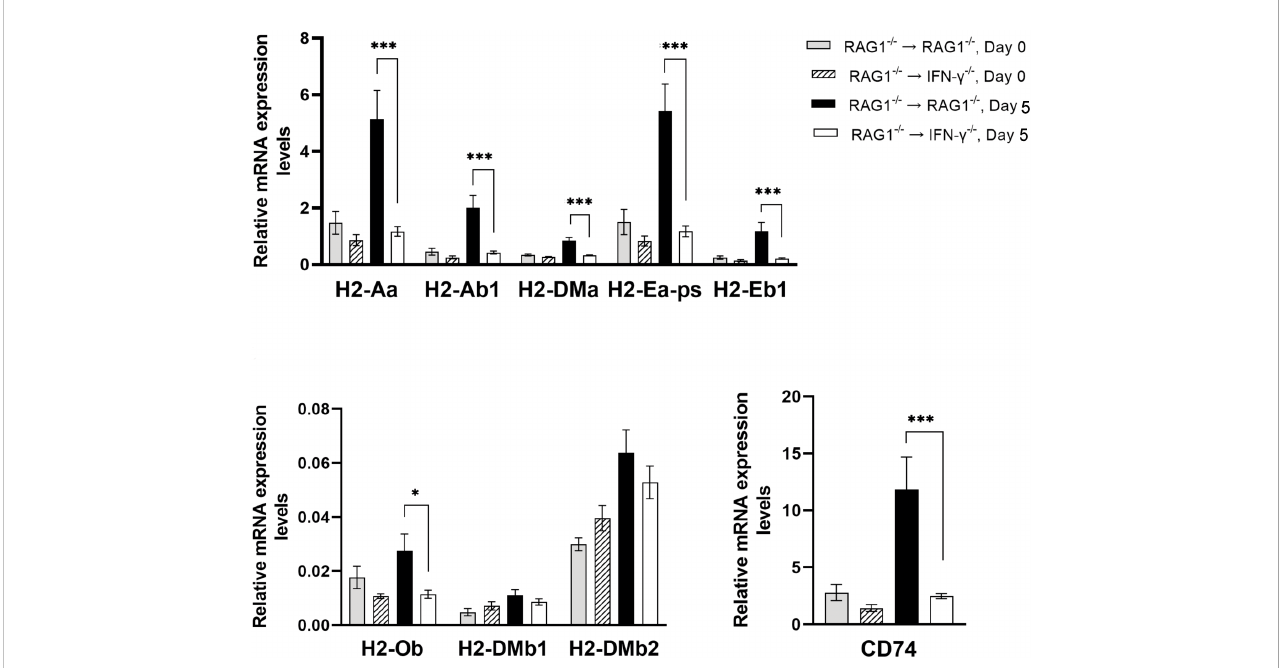
FIGURE 7 Cerebral mRNA levels for the molecules involved in antigen presentation for activating CD4 + T cells are upregulated by IFN- g production by brain- resident cells during reactivation of cerebral T. gondii infection. For the details of experimental methods, see the legend of Figure 1. The mRNA levels for 9 MHC class II molecules were measured at both Day 0 and Day 5 in the brains of both groups of mice were measured using NanoString nCounter Mouse Myeloid Innate Immunity Panel. * P <0.05 and *** P <0.001. The data were combined from two independent experiments (n=5 for Day 0 and n=7 for Day 5 in both RAG1 -/- → RAG1 -/- and RAG1 -/- → IFN- g -/-